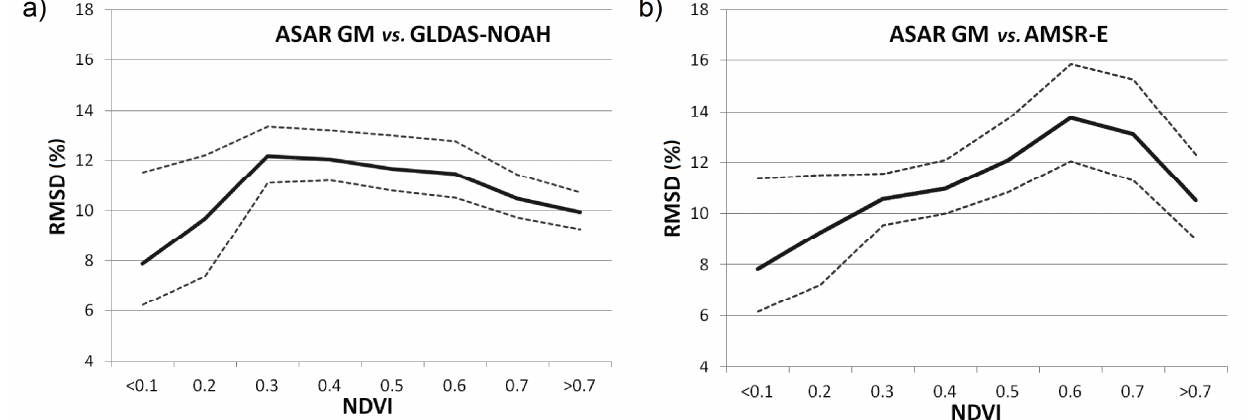
Figure 9. The root mean square difference (RMSD) as a function of average Normalized Difference Vegetation Index for: ( a ) Advanced Synthetic Aperture Radar (ASAR) Global Monitoring (GM) vs. the Noah model from the Global Land Data Assimilation System (GLDAS-NOAH) Surface Soil Moisture (SSM); and ( b ) ASAR GM vs. Advanced Microwave Scanning Radiometer for Earth Observing System (AMSR-E) SSM. The solid line represents the median value; dashed lines represent the 25th and 75th